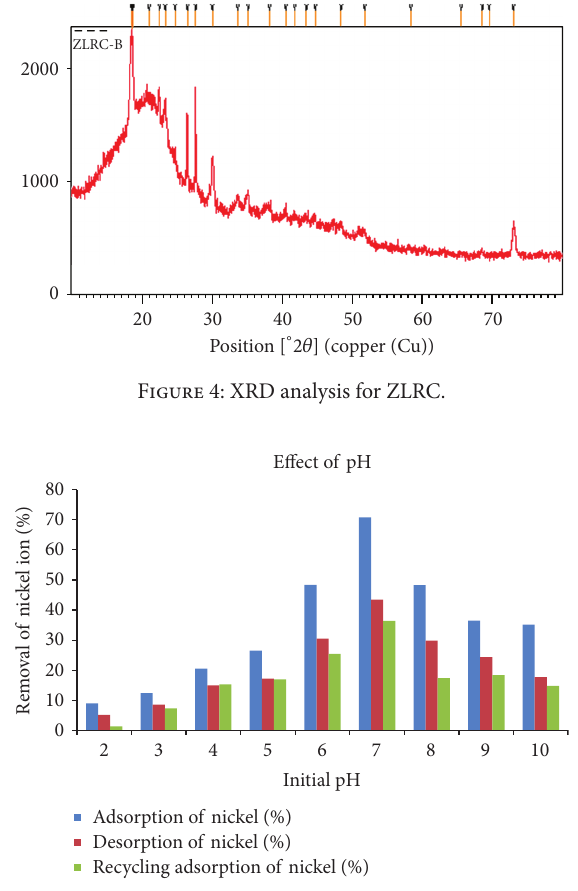
Recycling adsorption of nickel (%) F 5: Effect of pH on the adsorption, desorption, and recycling ion. [Ni] = 1000mg/L; contact time = 2h; adsorption of Ni adsorbent dose = 0.2g/50mL. 2+